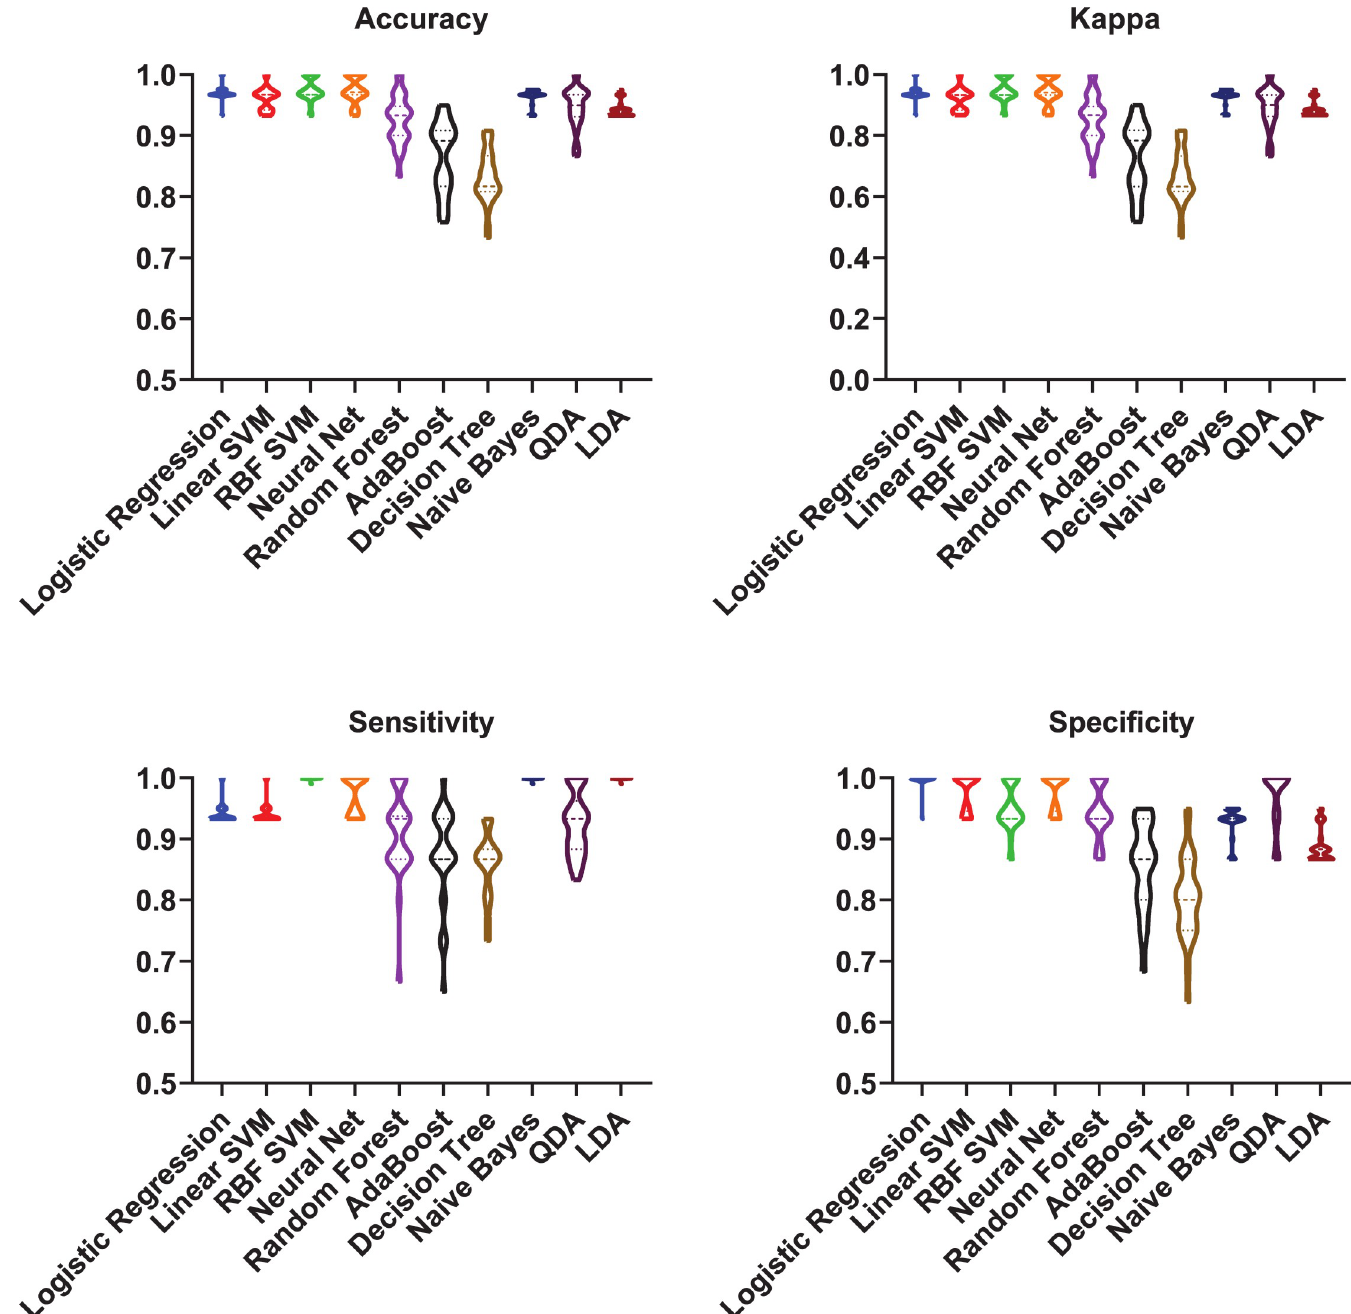
Fig 4. Supervised machine learning prediction of benzylpenicillin resistance spectral signature profiles. Prediction performance results of ten different classifiers (logistic regression, linear SVM, RBF SVM, MLP neural network, decision tree, random forest, AdaBoost, na ï ve Bayes, quadratic discriminant analysis (QDA) and linear discriminant analysis (LDA)) that were used to classify the benzylpenicillin resistance profiles are shown on the X-axis. Four performance indicators have been used to evaluate the classification: accuracy, kappa, sensitivity and specificity. The scores for each performance metric are indicated in the Y-axis. https://doi.org/10.1371/journal.pcbi.1009108.g004 characterised the molecular functions (MF), cellular components (CC), and biological pro- cesses (BP) they may carry out. RpmJ and RpmD are the 50S ribosomal proteins L36 and L30, respectively. HU is a histone-like DNA-binding protein, which interacts with DNA to protect